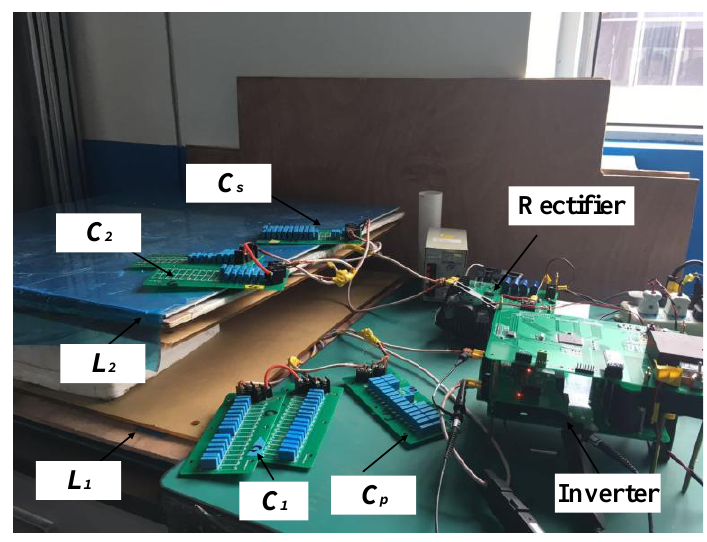
Figure 5. Experiment platform. Table 1. Double-sided LCC resonant WPT system parameter